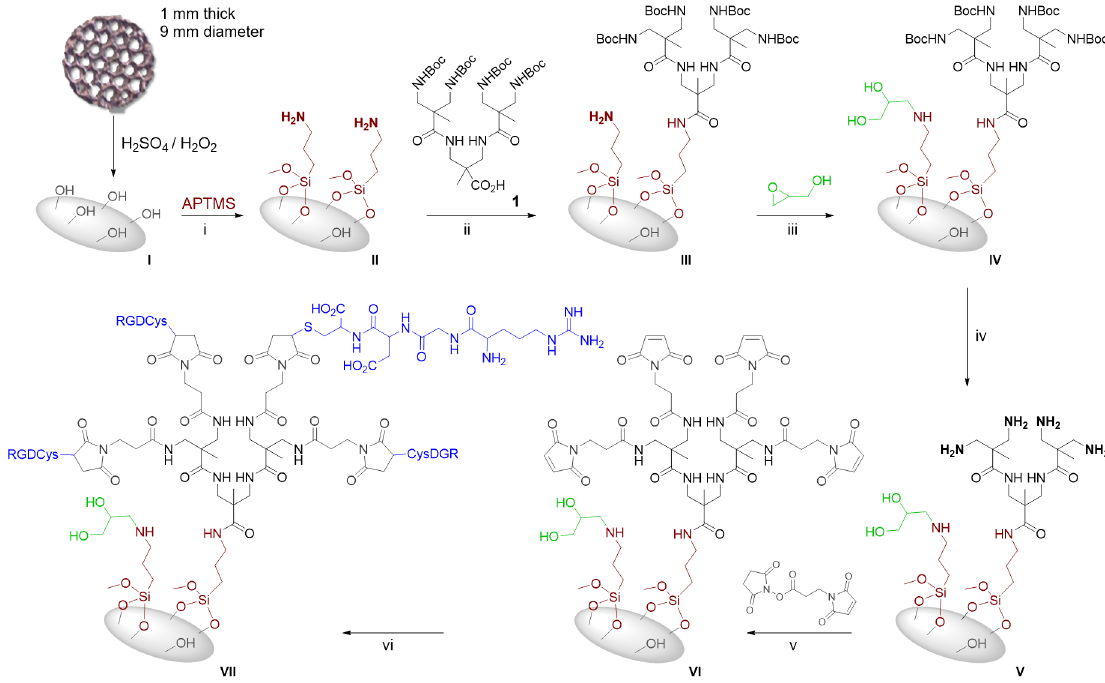
Figure 1. Covalent modification of Ti disk: (i) EtOH; (ii) CDI/CH 3 CN; (iii) propanol; (iv) HCl (4 M) in dioxane/THF; (v) N,N -Diisopropylethylamine (DIPEA) /DMF; (vi) phosphate buffer saline (PBS).